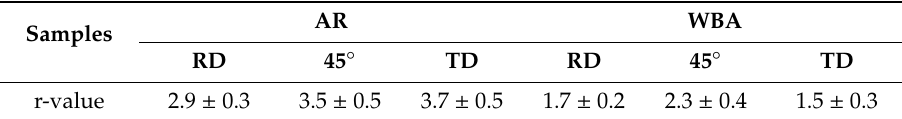
Figure 10. Erichsen values of ( a ) as-rolled sheet and ( b ) WBA sheet. Table 2. r-value of various samples.